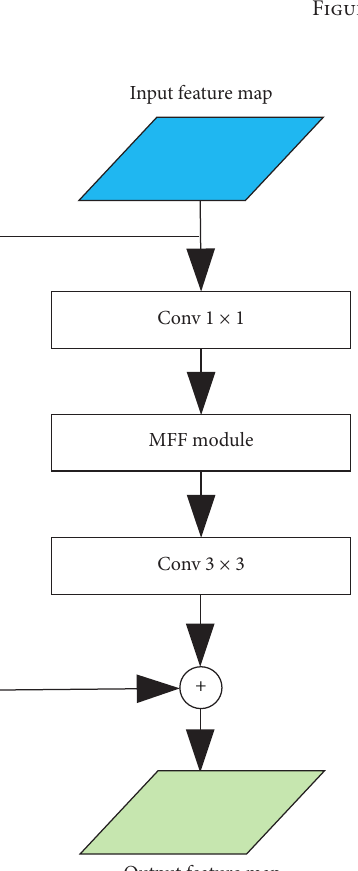
Figure 2: An MFF